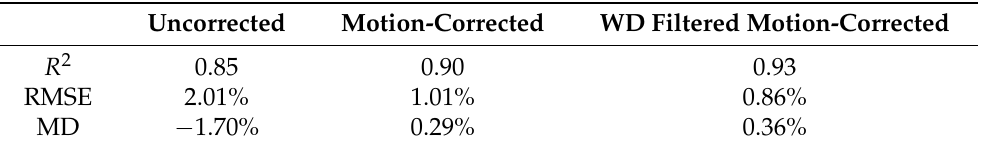
Table 1. Statistical indicators evaluating the comparison between FDWL (with and without correction) and fixed LiDAR TI measurements at the 10 min level. Uncorrected Motion-Corrected WD Filtered